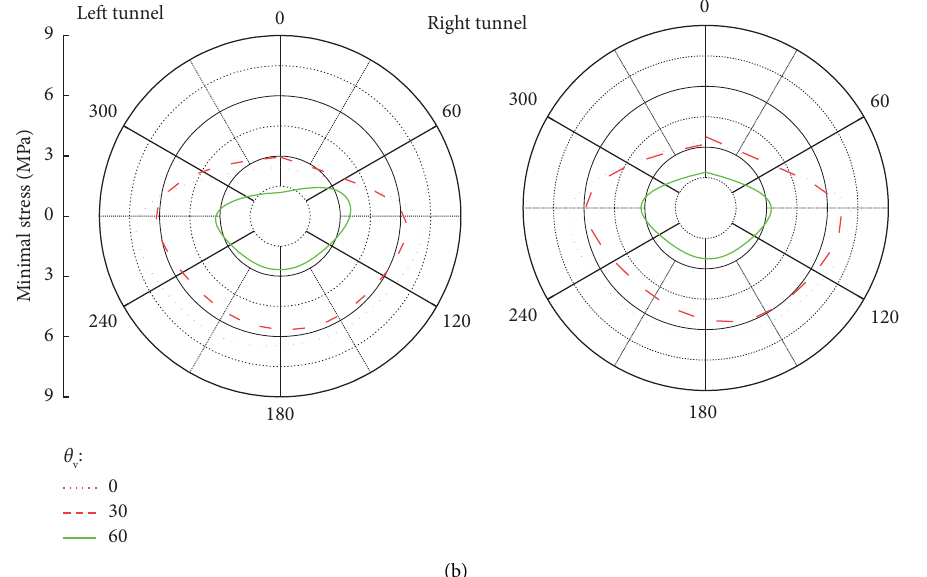
Figure 10: Amplitude distribution of principal stress when SV wave is incident at 25: (a) maximum principal stress and (b) minimum principal